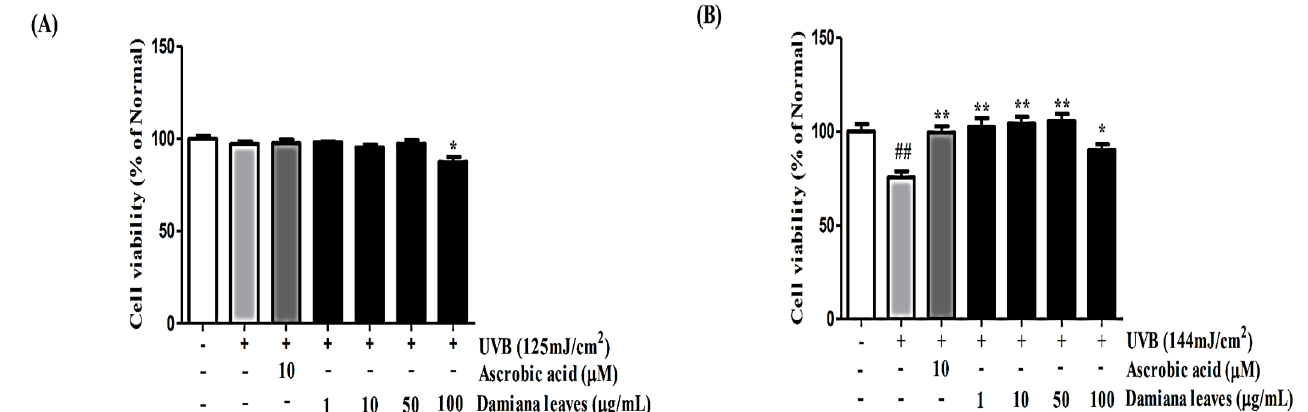
Figure 3. Effect of Damiana leaves extract on cell viability of HaCaT ( A ) and HDF ( B ) cells. Data are presented as the mean ± SD. # and * indicate significant differences between the non-treated cells and induced groups, respectively. ## p < 0.01 vs. the non-treated group. * p < 0.05 and ** p < 0.01 vs. the induced control.